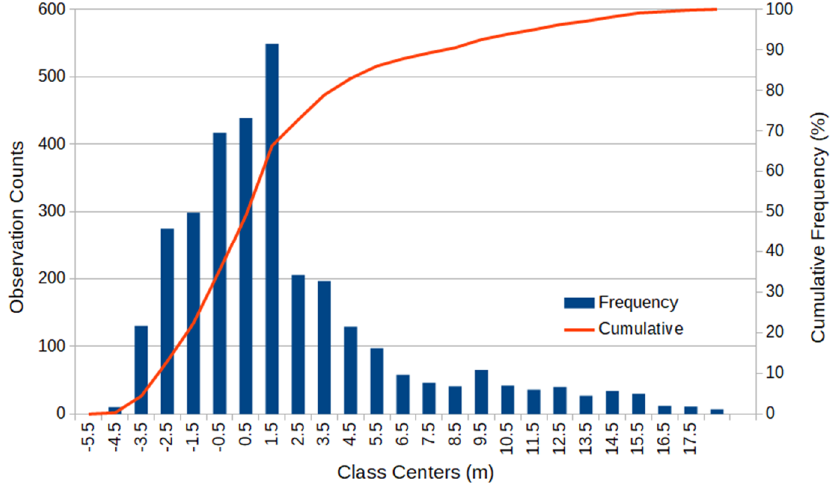
Figure 21. Histogram and cumulative distribution of the 1st order (plane) surface fit errors for the ( h DTM − h SONAR )